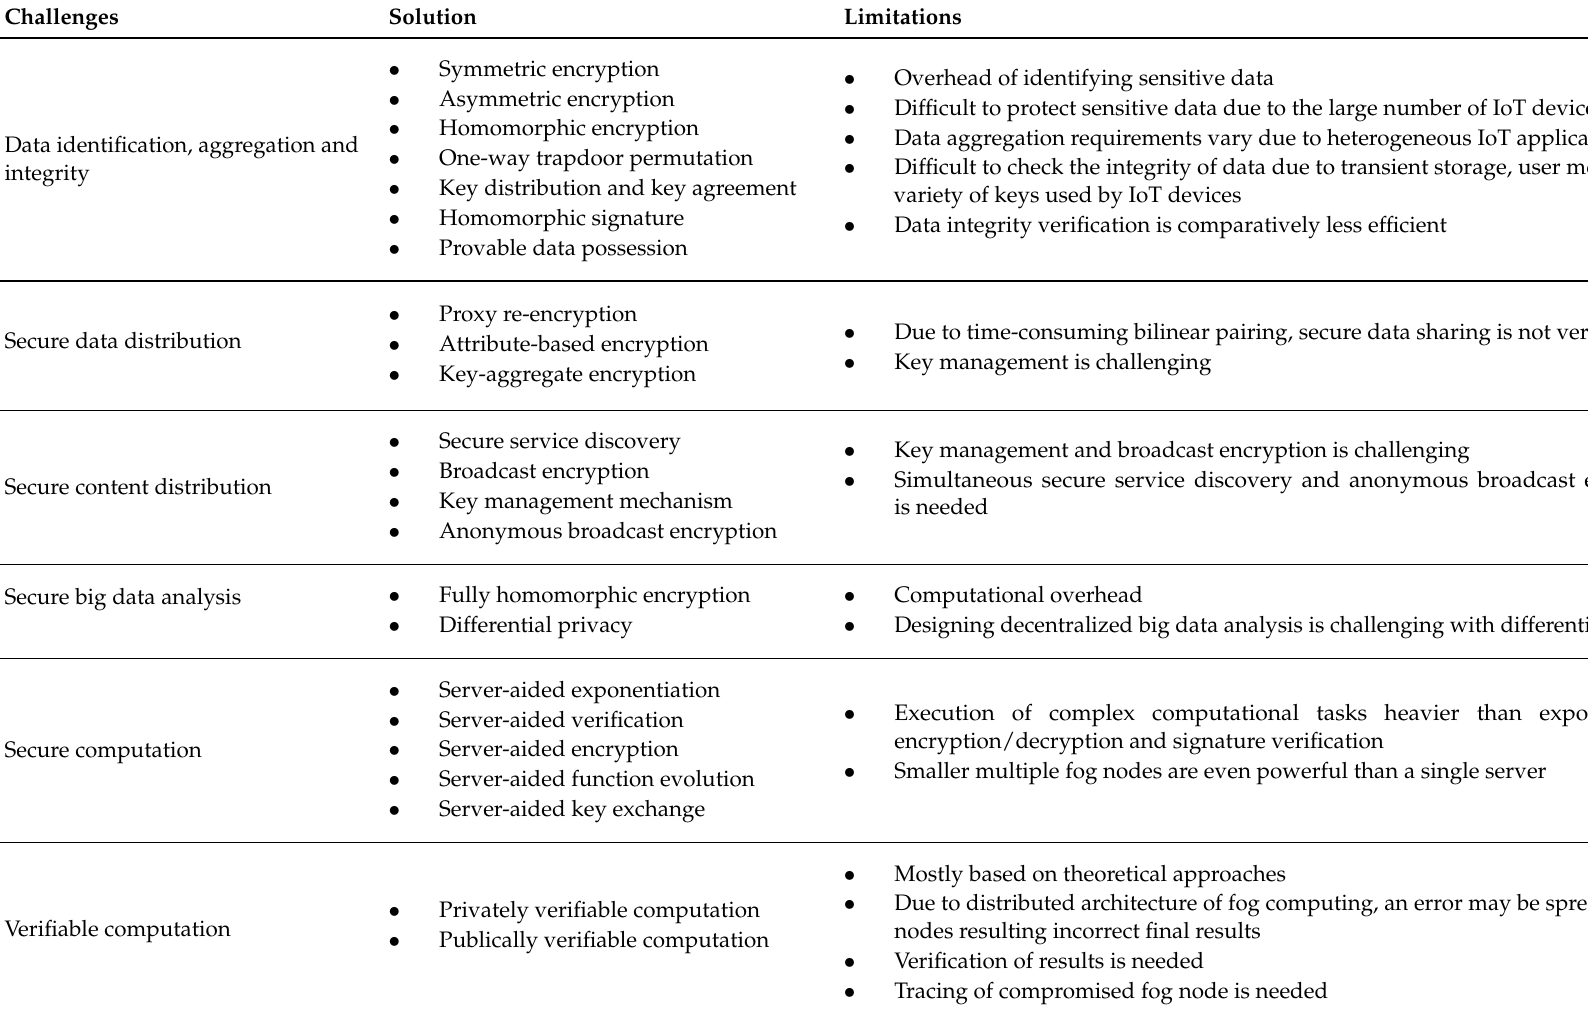
Table 4. Data center level challenges and solutions with respective